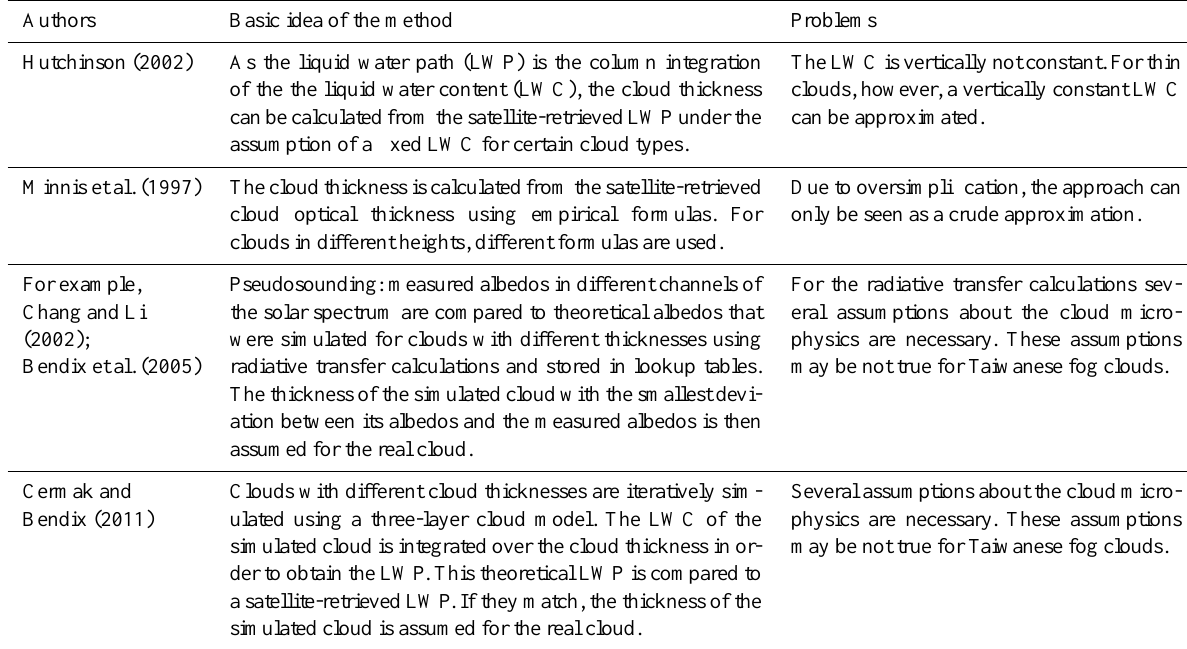
Table 2. Different cloud thickness retrieval